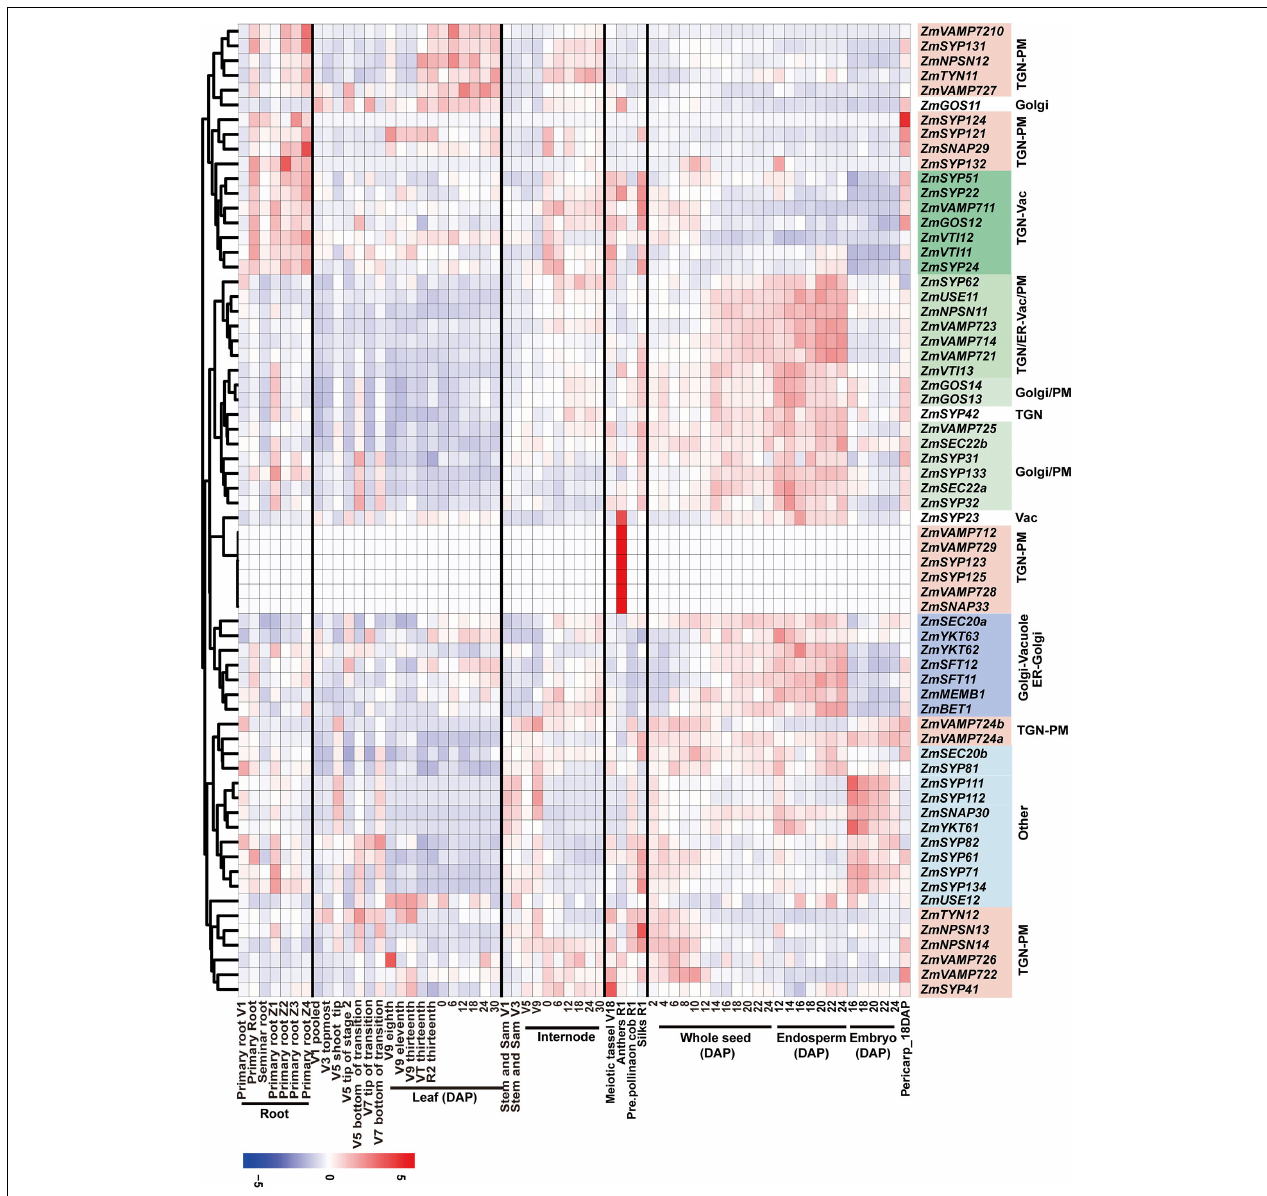
FIGURE 2 | The spatiotemporal expression profiles of maize genes encoding SNARE proteins. The expression patterns of SNARE-encoding genes are analyzed based on the reads per kilobase per one million reads (RPKM) of 64 maize tissue-specific samples. The blue, white, and red colors indicate the low, medium, and high gene expression values,